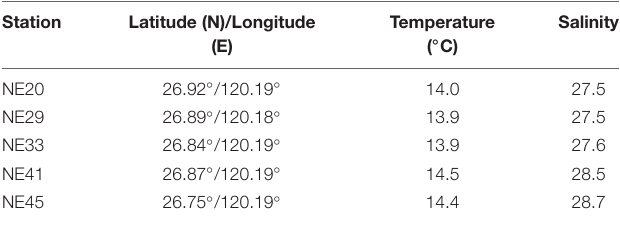
TABLE 1 | Physicochemical variables of the surface water and locations of the sampling